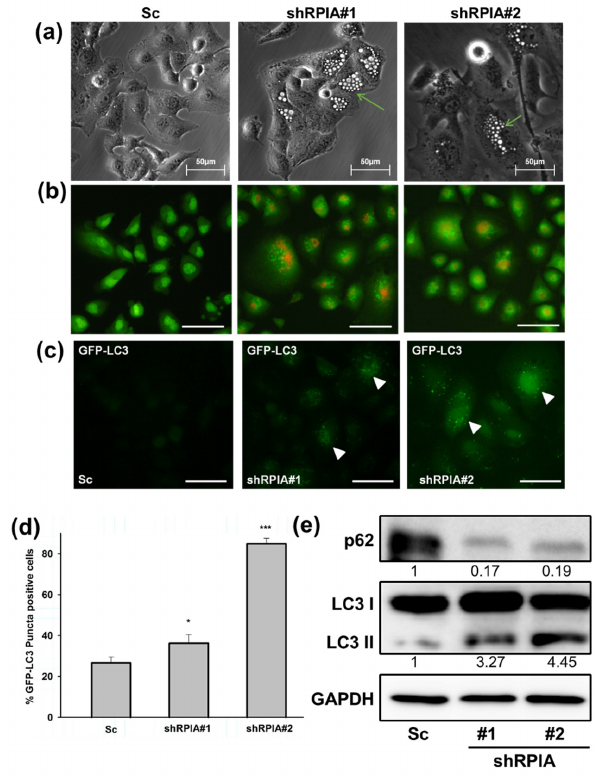
Figure 5. Knockdown of RPIA induced autophagosome formation, reduced p62 and increased LC3-II protein levels in lung cancer cells. ( a ) Knockdown of RPIA triggered autophagic vacuoles morphology observed by microscopy. Magnification: × 200. ( b ) Suppression of RPIA in A549 cells increased acridine orange staining detected by fluorescence microscopy. Magnification × 200, Scale bar represents 200 µ m. ( c ) RPIA knockdown lung cancer cell displayed more LC3-GFP punctae by fluorescence microscopy. Magnification × 200. Scale bar represents 200 µ m. ( d ) The percentage of the LC3-GFP puncta-positive cells was quantified and the statistical analyses were performed by Student t -test, * p < 0.05, *** p < 0.001. ( e ) Knockdown of RPIA increased LC3-II and reduced p62 expression in lung cancer